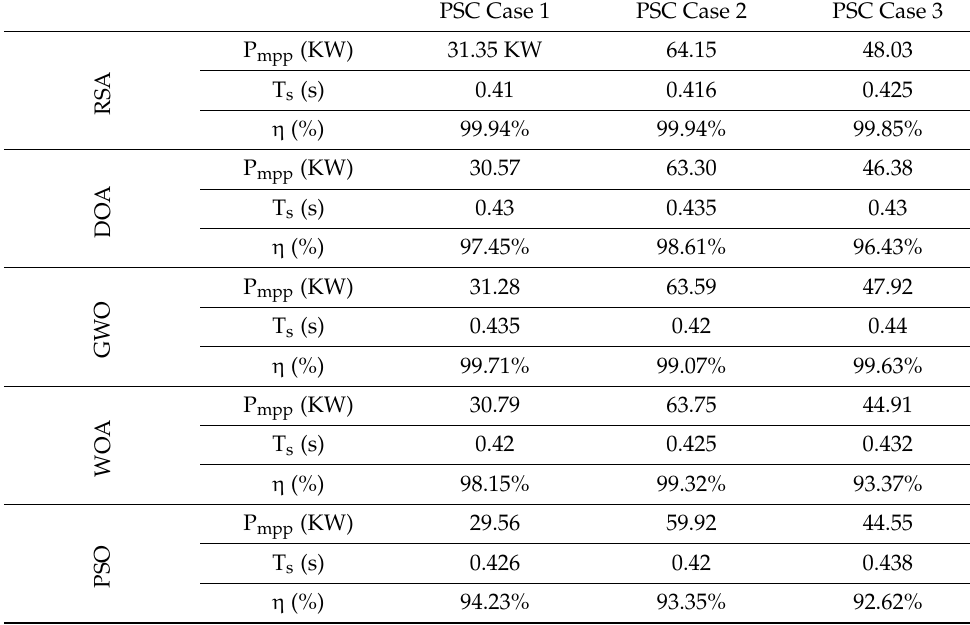
Table 4. Comparison of PSC simulation